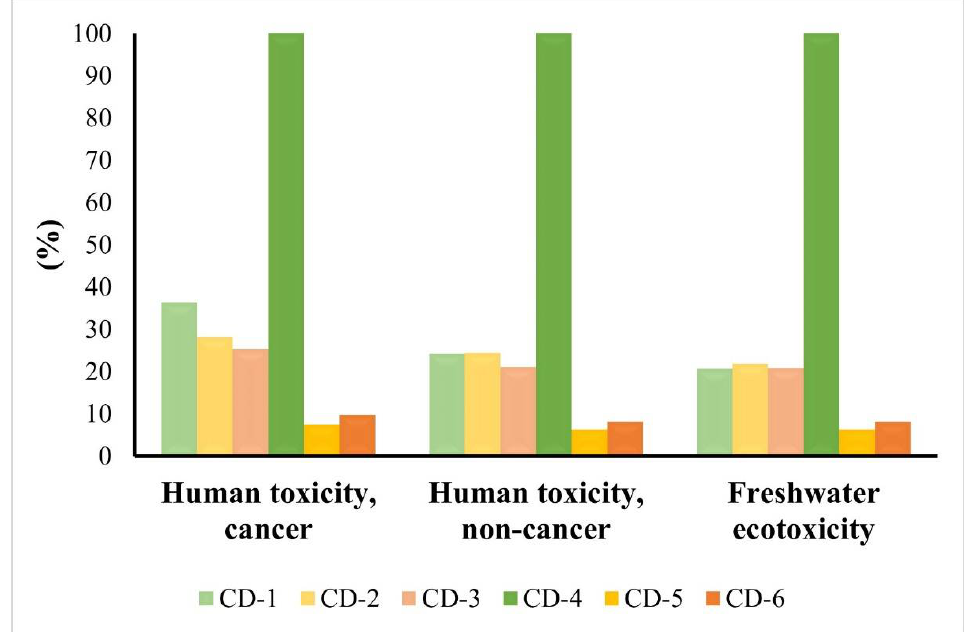
Figure 13. Relative environmental impacts of all syntheses under study, applying USEtox method. Green scale refers to hydrothermal treatments; Yellow scale refers to microwave-assisted treatments; Orange scale refers to calcination treatments.